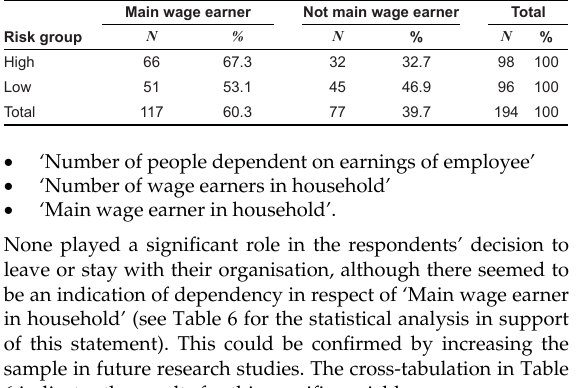
TABLE 6 Cross-tabulation for variable ‘Main wage earner in household’